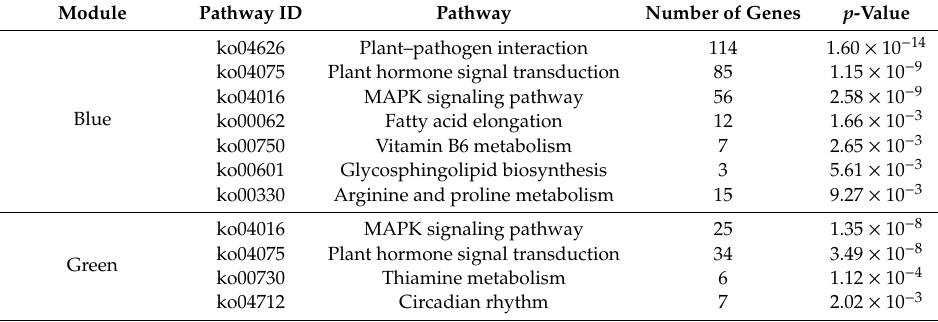
Table 3. Significant Kyoto Encyclopedia of Genes and Genomes (KEGG) pathways of four significant WGCNA